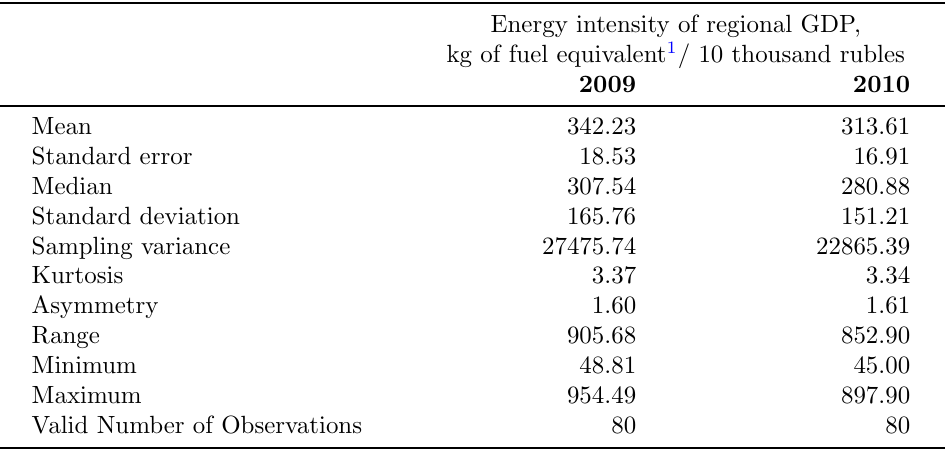
Table 1: Descriptive statistics of energy intensity of Russian regional economy systems. Calculated according to the statistical digest “Industry of Russia-2012”